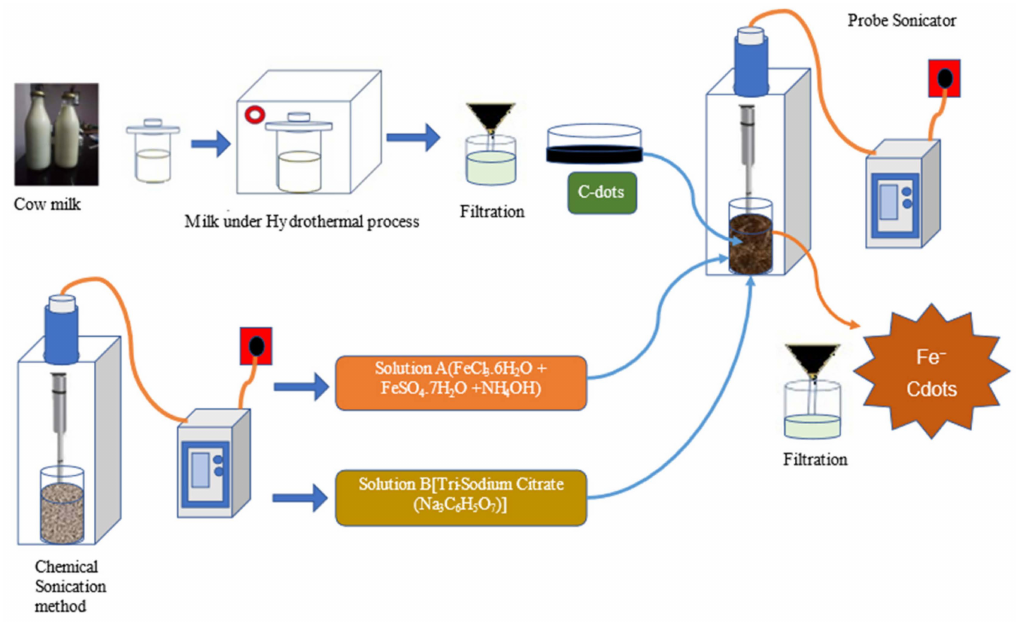
Figure 8. The synthesis process of C-dots; Fe 3 O 4 @PSA-C and Fe 3 O 4 @PSA samples using the Hy- drothermal assisted chemical sonication method. Table 2. Specification and content of Amul cow milk. Packaging